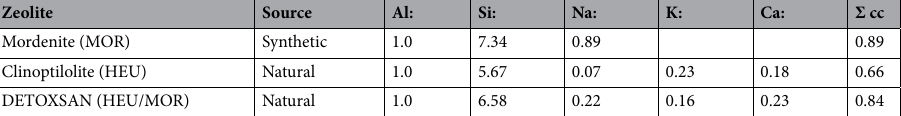
Table 1. Molar composition of the zeolite samples in relation to aluminium as well as the sum of charge- compensating cations (cc).